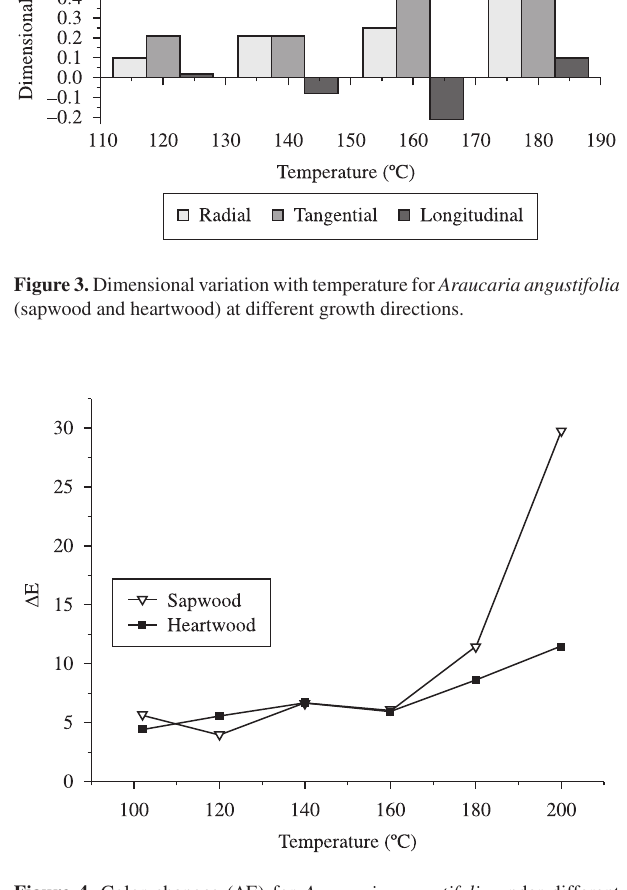
Figure 4. Color changes ( ∆ E) for Araucaria angustifolia under different temperature